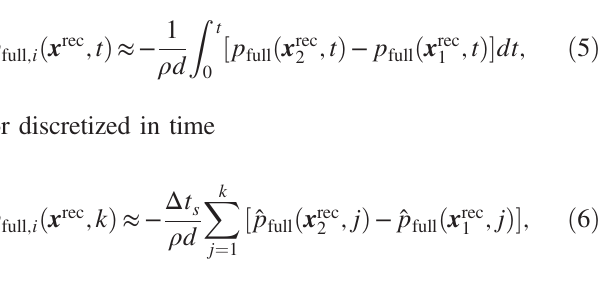
FIG. 3. Demonstration of real-time particle velocity estimation and wave field separation in 1D using a Ricker wavelet with a center frequency of 2 kHz as input. The top panel displays two pressure measurements recorded at x rec 1 and x rec 2 . Pressure and (estimated) particle velocity are extrapolated to x rec by evaluating Eq. (4) in real time on the WaveLab system. The scaling by the acoustic impedance of air and convolution with ˆ α ð k Þ is included in the extrapolation Green ’ s functions to obtain a real-time estimate of the right-going pressure ⃗ p ð x rec ; k Þ . The left-going pressure ⃖ p ð x rec ; k Þ is obtained by subtracting ⃗ p ð x rec ; k Þ from the total pressure field offline. The successful separation of the wave field is underlined by the low residual energy of 0.37% and 1.09% in the left- and right-going arrivals compared to the total field contained in the left and right shaded box,